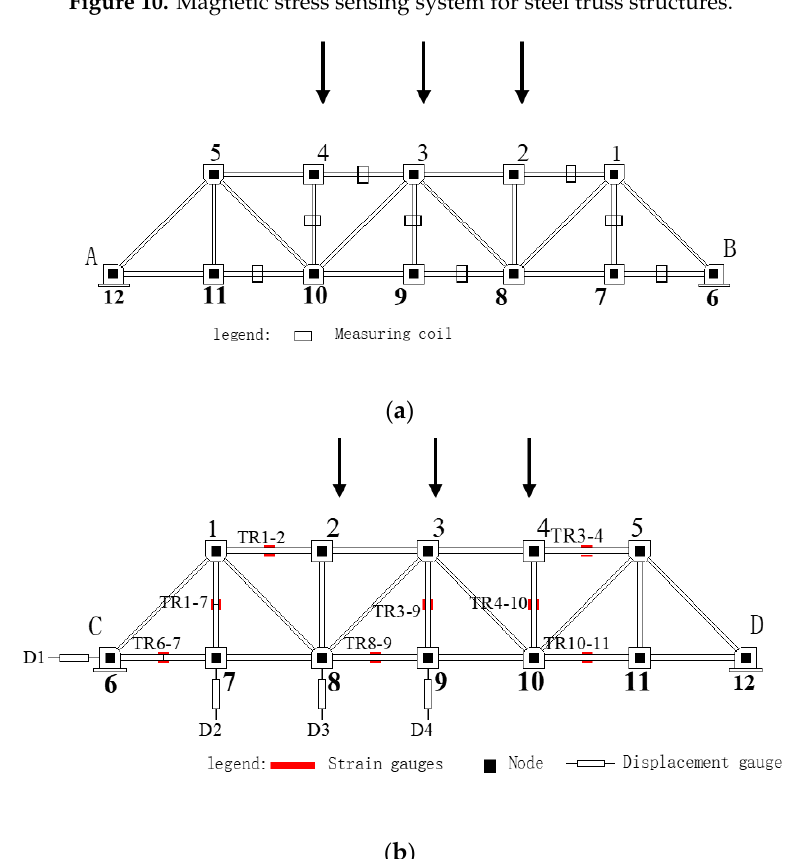
Figure 10. Magnetic stress sensing system for steel truss structures.